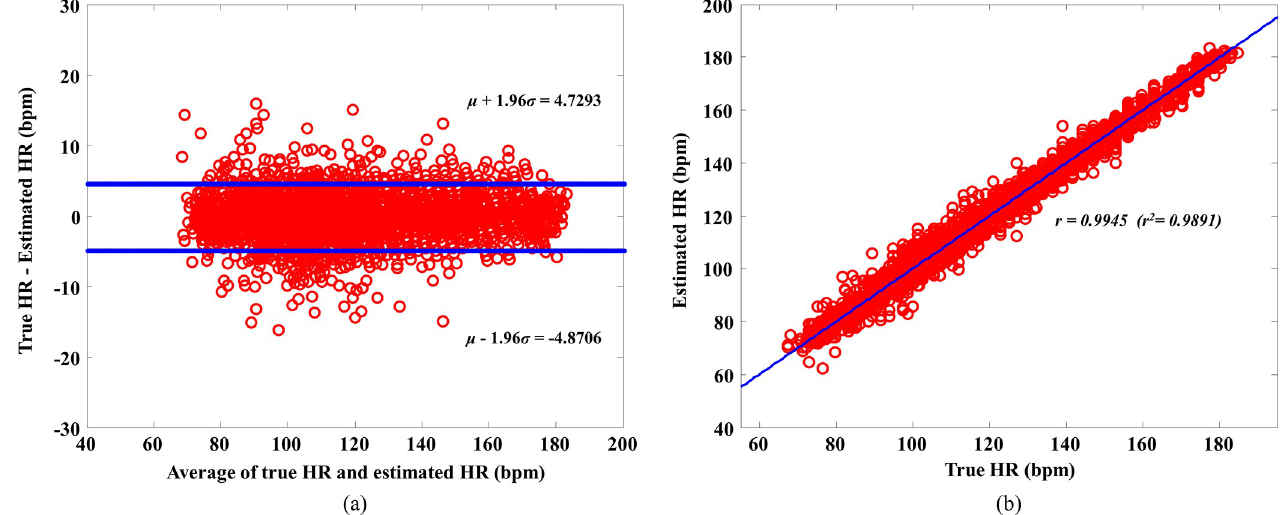
Fig 8. Bland–Altman plot and correlation. (a) Bland–Altman plot of estimated and true HRs and (b) correlation for the proposed FSM-SGPS algorithm.